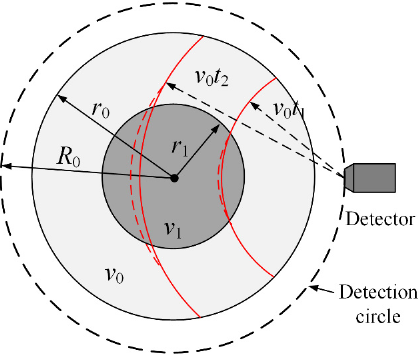
Fig. 3. Schematic showing heterogeneous sound speed distri- bution. Modi¯ed version of Fig. 3 in Ref. 23.